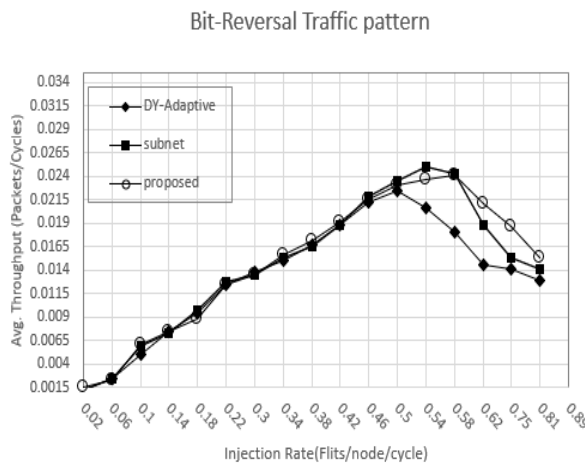
Fig. 15 Average throughput evaluation under synthetic Bit-Reversal traffic